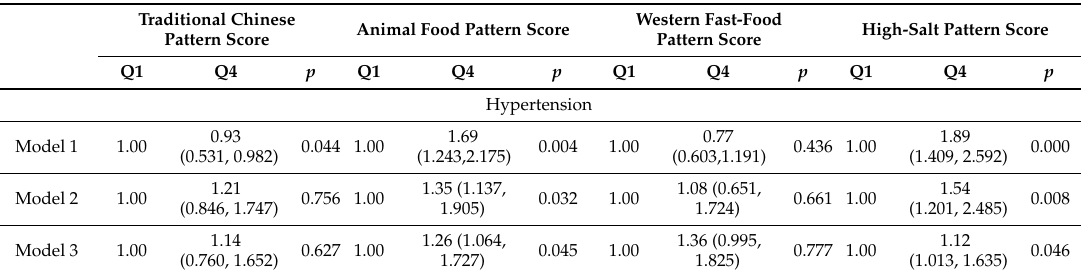
Table 4. Multivariable adjusted prevalence rate ratio (95% CI) for hypertension across the quartile (Q) categories of dietary pattern